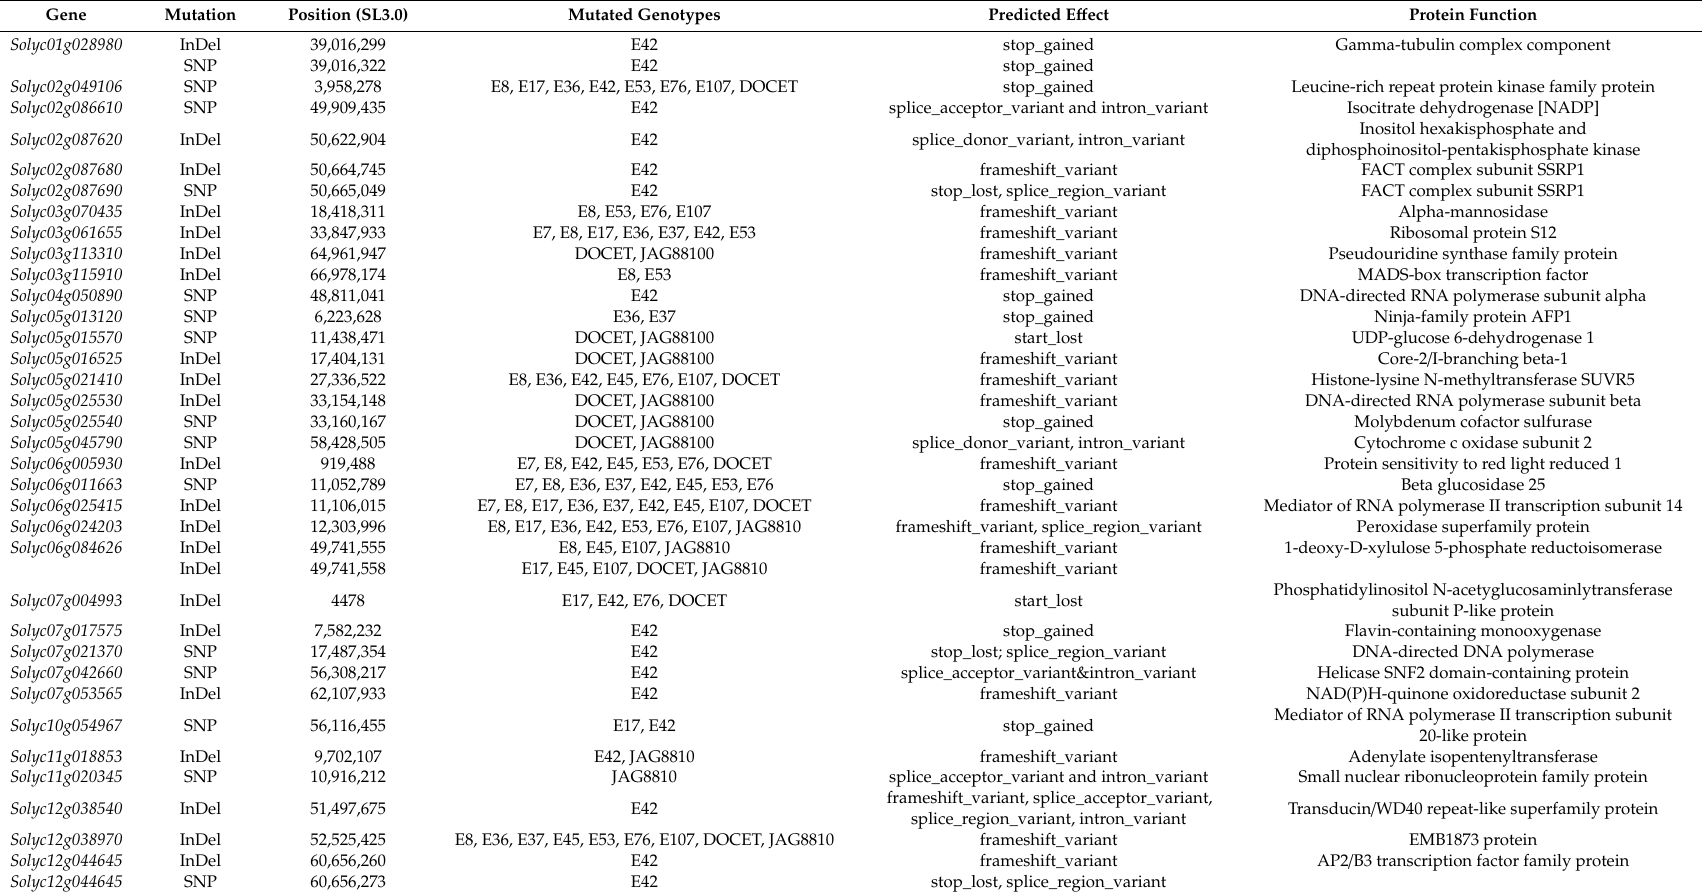
Table 4. List of genes a ff ected by SNPs / InDels mutations with high impact. For each gene, the position in the tomato genome (version SL3.0), the genotypes carrying the mutation, the predicted e ff ect of the mutation, and the protein function are